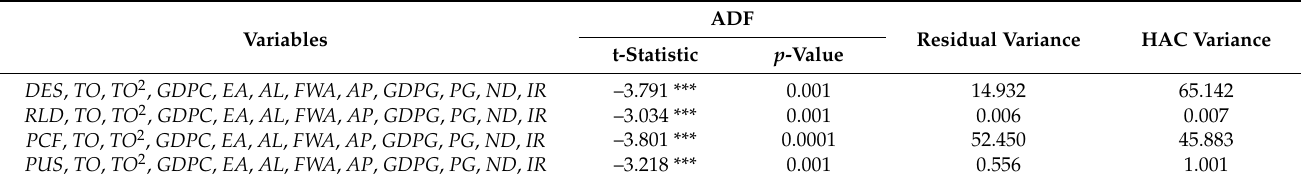
Table 4. Results of Kao cointegration